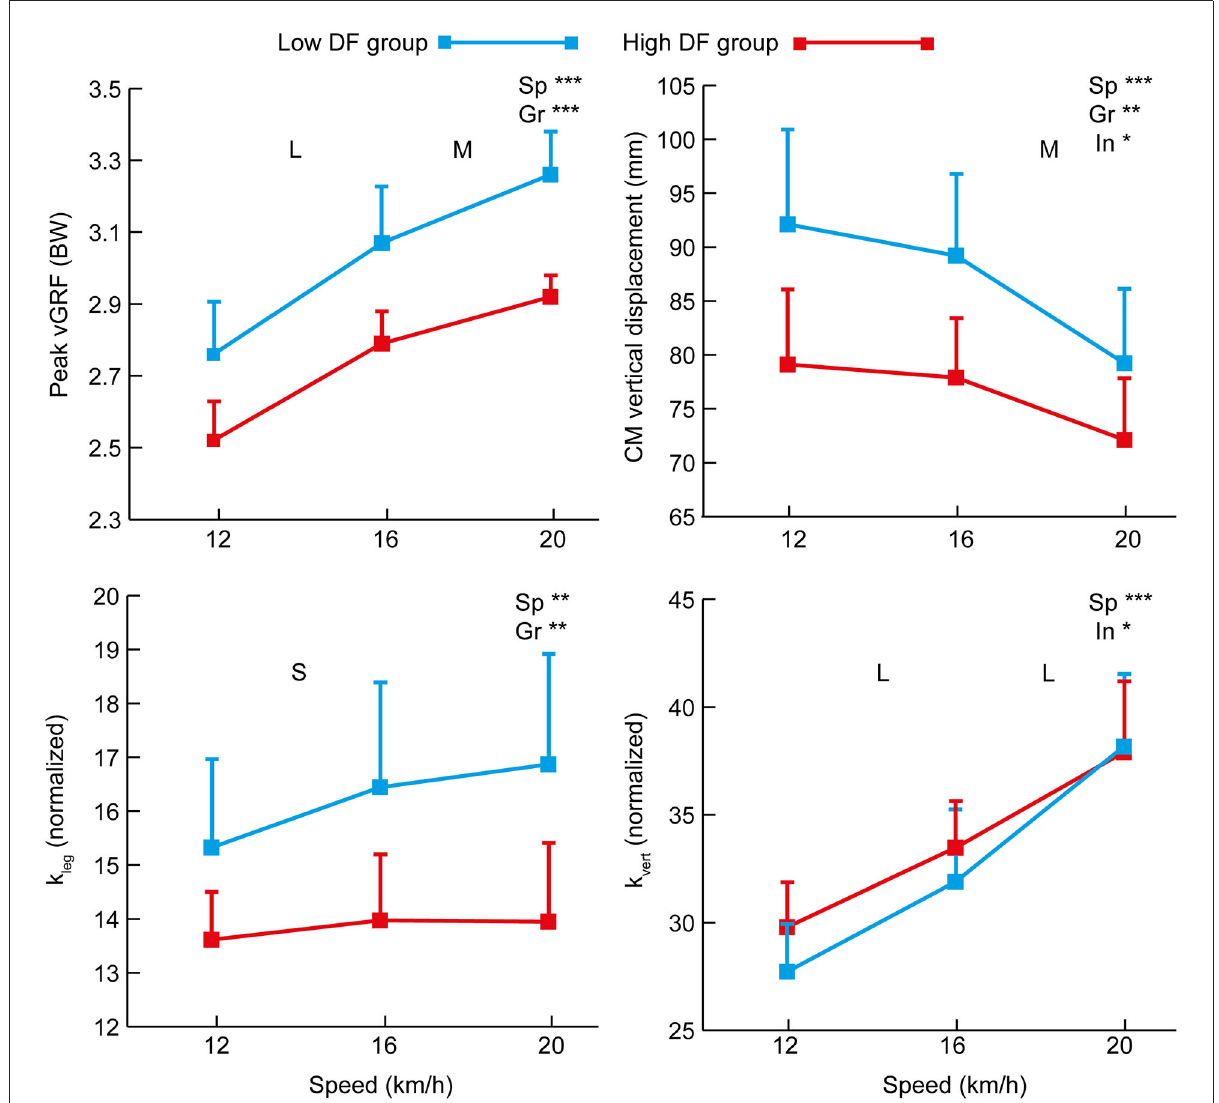
FIGURE2 Mean ( + SD) values for vGRF, CM vertical displacement, and global stiffness variables at each of the three testing speeds for the high and low DF groups. Overall effects for speed (“Sp”), group (“Gr”) and interaction (“In”) are annotated on each figure where statistically significant ( p < 0.05 *, p < 0.01 **, or p < 0.001 ***). The effect size (Cohen’s d ) for differences between successive test speeds is annotated as small (S), moderate (M), large (L), very large (VL), or extremely large